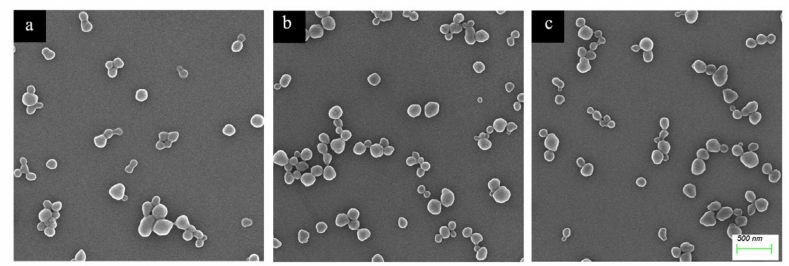
Figure 6. SEM photographs of ( a ) MIP-PHEMA, ( b ) MIP-PIA, and ( c ) MIP-PDEAEMA.